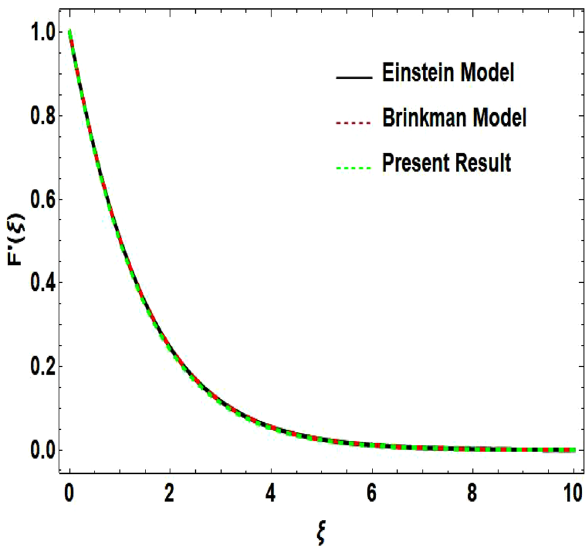
Figure 4. Velocity curve relative to different models.